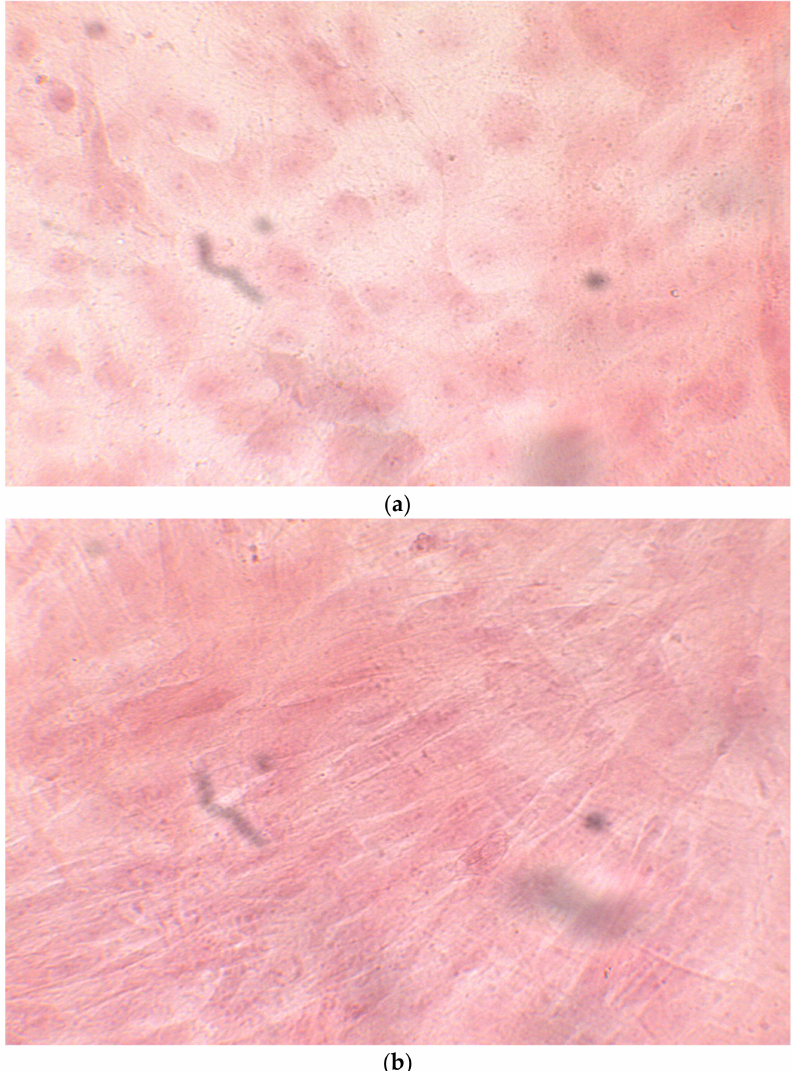
Figure 7. CTR4#5 P20: despite being positive to the alkaline test, as seen in the phase optical microscope, the alizarin red staining test shows a di ff erent structure from the other clones that appear more spherical ( a , b